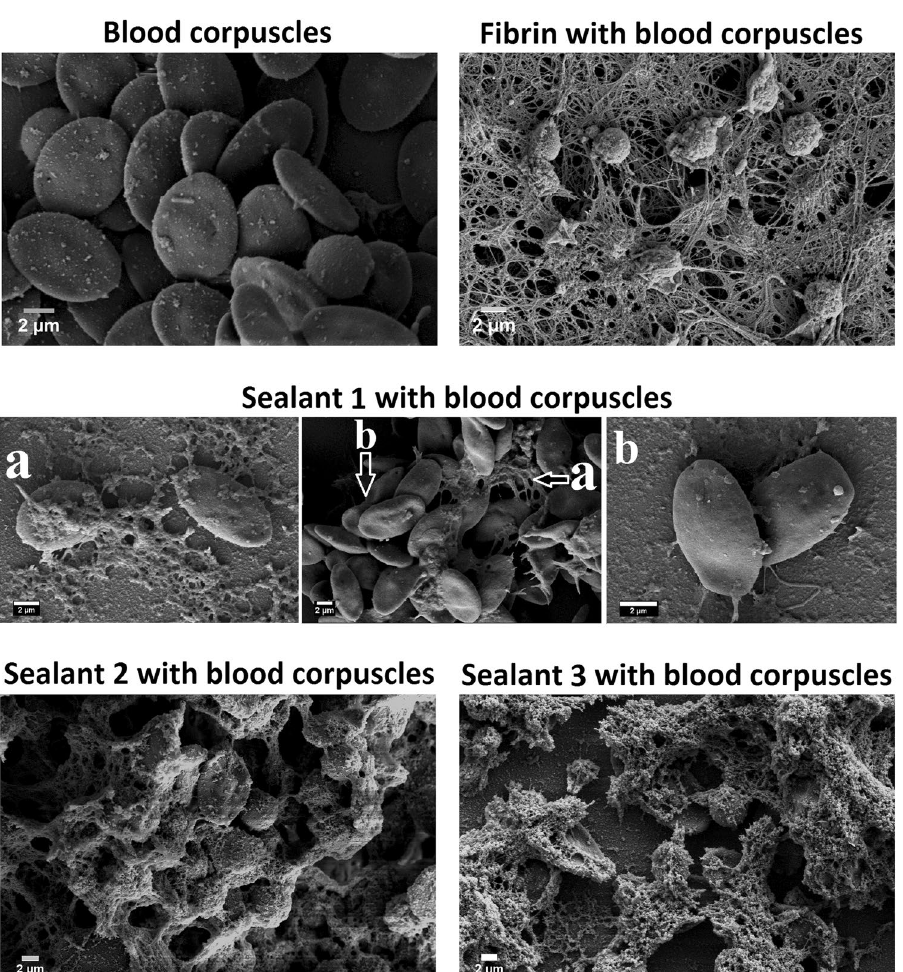
Figure 7. SEM images of indigenous fibrin free blood corpuscles and blood corpuscles with fibrin and sealants. SEM image (resolution 7.79 KX) of sealant 1 with blood corpuscles shows ( a ) blood corpuscles loosely entrapped by sealant 1 and ( b ) blood corpuscles not entrapped by sealant 1. The resolution of SEM images of indigenous fibrin free blood corpuscles and blood corpuscles with fibrin, sealant1(middle), sealant 2 and sealant 3 are 9.34, 9.01, 11.32, 5.99 and 5.82 KX, respectively. Scale bar of the SEM images are 2 μ